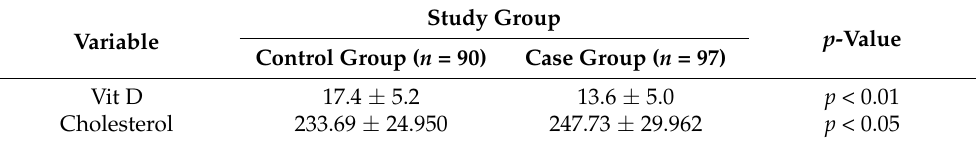
Table 2. Comparative analysis of biochemical variables between the study groups.